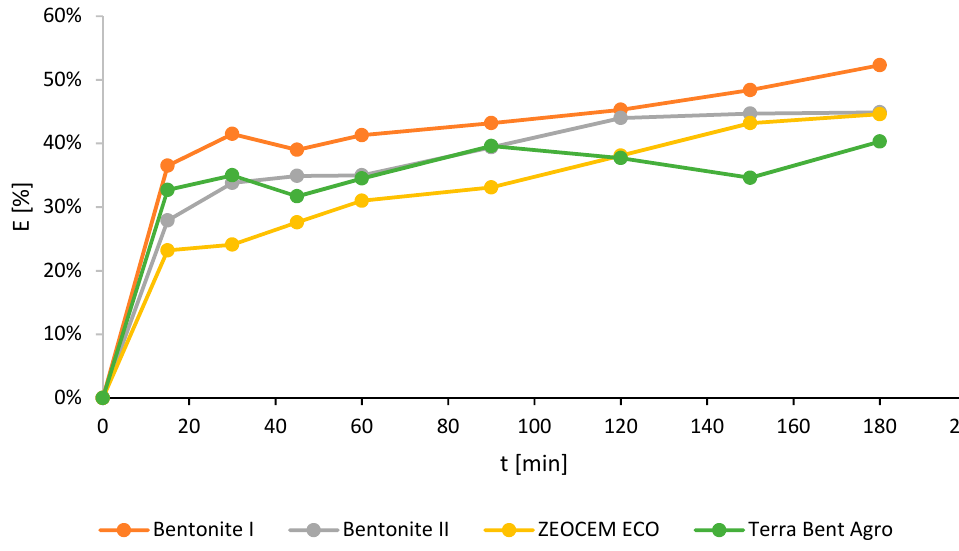
Figure 3. The ammonium ions removal e ffi ciency (E) for Bentonite I and II, Zeocem Eco, and Terra Bent Agro.